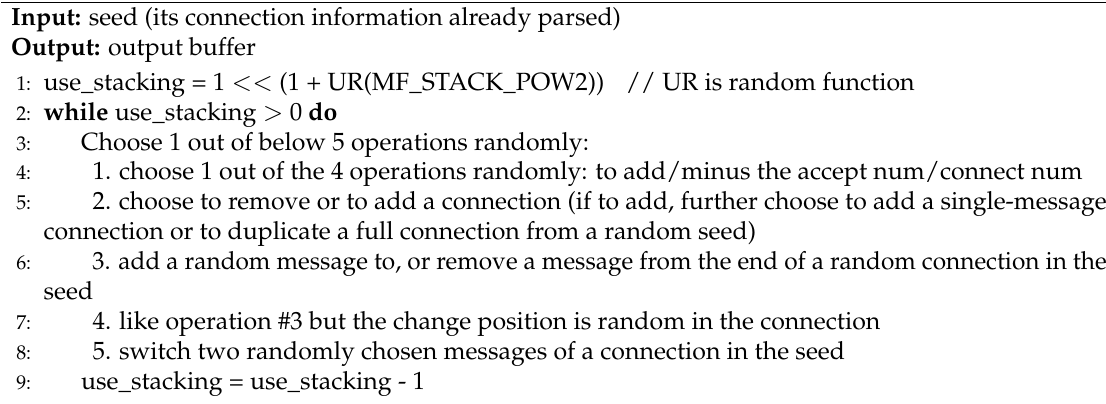
Algorithm 1 Message mutation